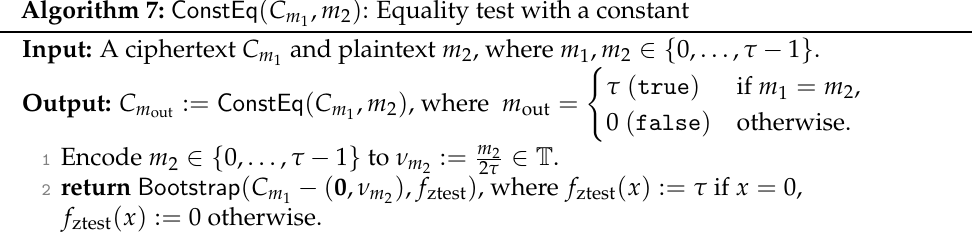
Algorithm 7: ConstEq ( C m